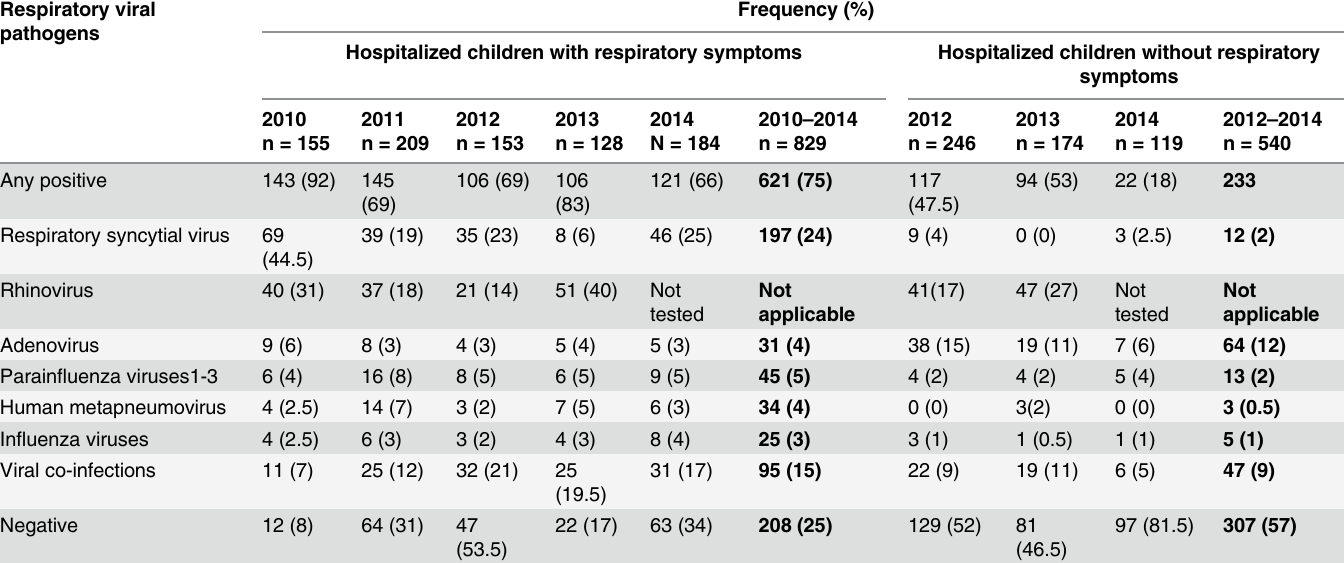
Table 1. The frequency of respiratory viral infections in children aged < 5 years hospitalized with and without respiratory symptoms in four surveil- lance hospitals, Bangladesh 2010 – 2014. Respiratory viral pathogens